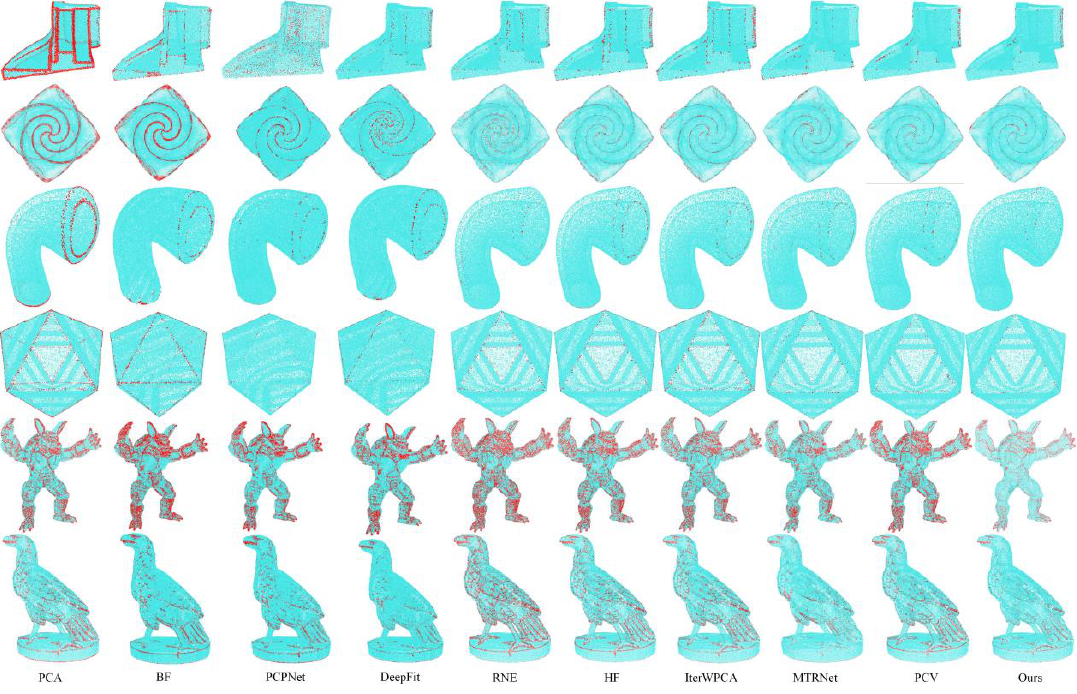
Figure 7. Visualization of NBPs on partial models of SharpFeature, NonUniform, and Details.